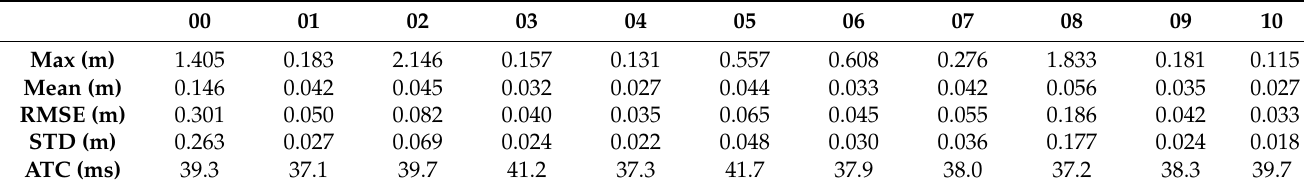
Table 10. APE results of KITTI dataset.